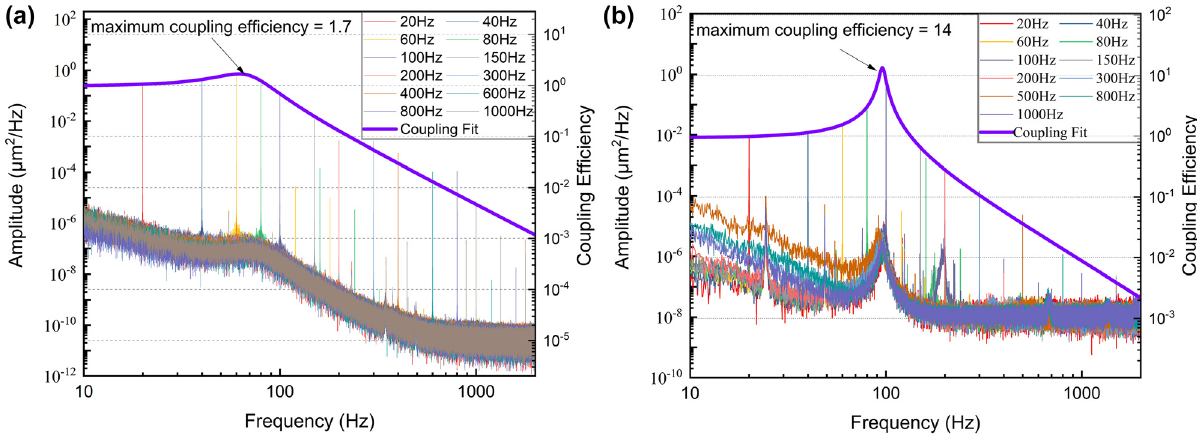
Figure 4: Orbital-translational coupling effects as a function of rotational frequency under two pressures. The PSD signals of the x coordinates using optical trap rotating at various rotational frequencies under (a), atmospheric pressure and (b), 1 mbar